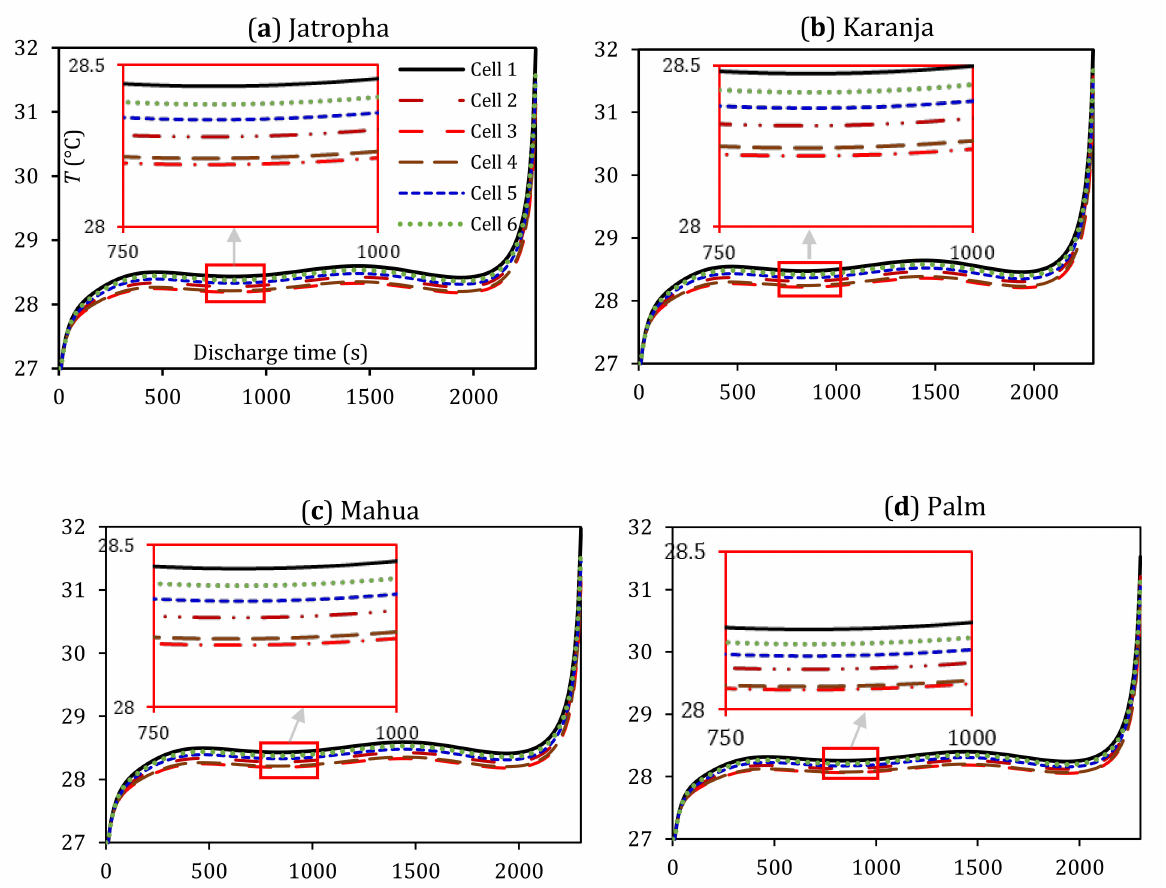
Figure 14. LIB cells temperatures versus discharge time at 3C discharge rate, using biodiesel cooling, showing ( a ) jatropha, ( b ) karanja, ( c ) mahua, and ( d ) palm oil FAMEs as